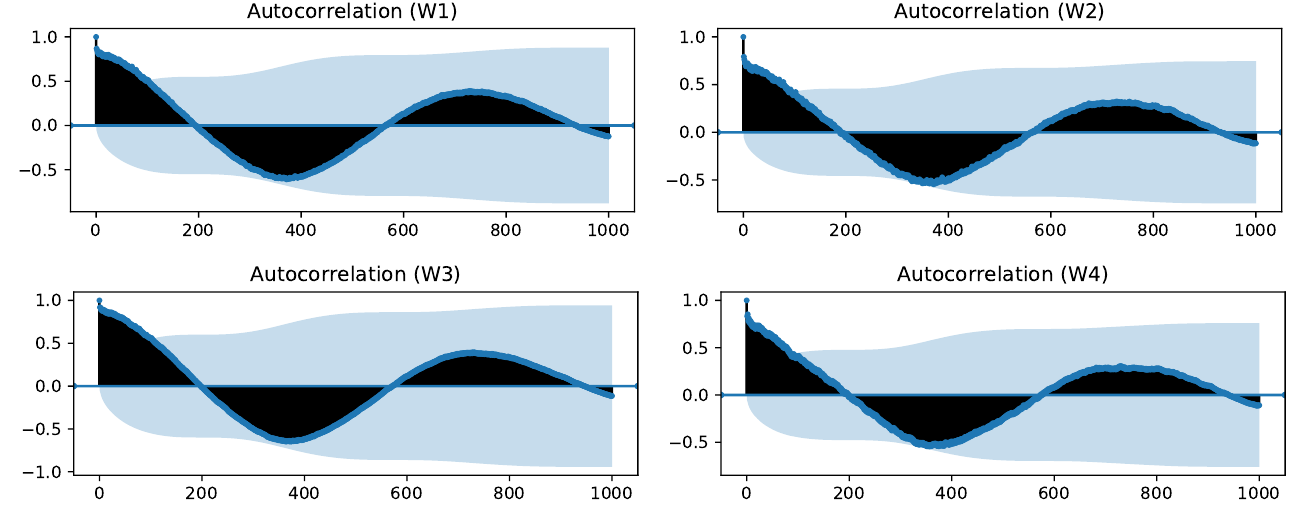
Figure 9. Autocorrelation function for the four smoothed MC signals from